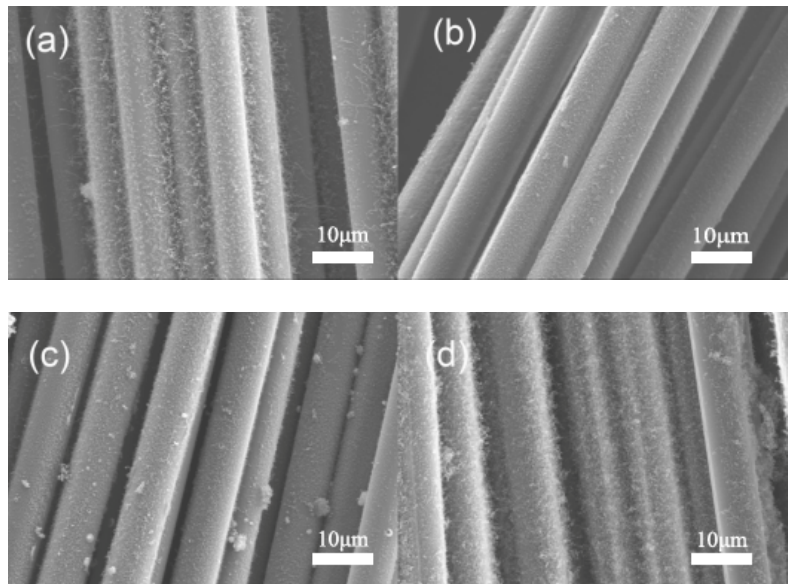
Figure 5. Surface morphology of CFs with CNTs treated with different EAO intensities. ( a ) 50 C/g, ( b ) 100 C/g, ( c ) 150 C/g, ( d ) 200 C/g.